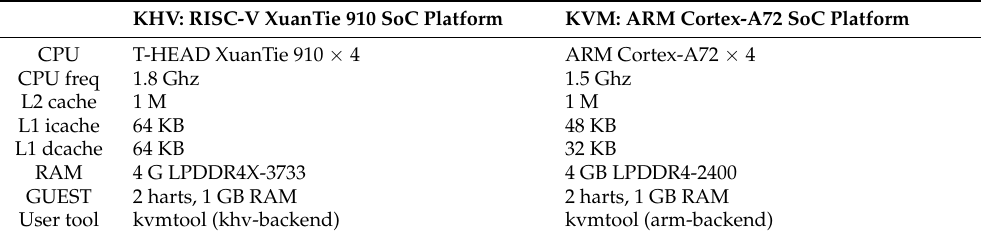
Table 2. Introduction to the test platform.